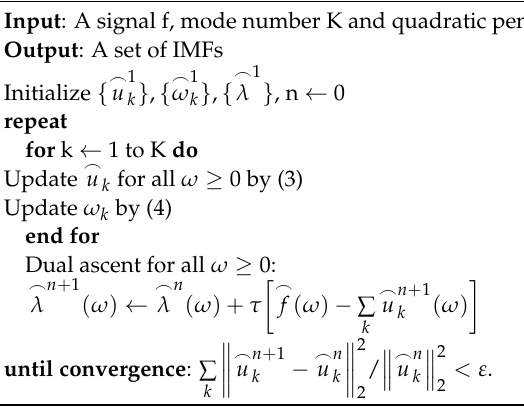
Algorithm 1. The default ε value is 1 × 10 − 7 . Algorithm 1 :